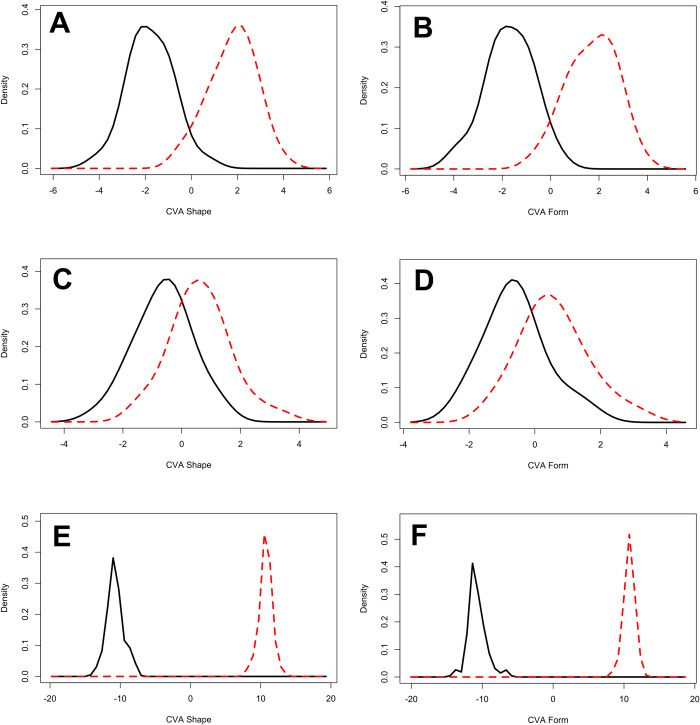
Distribution density plots for Canonical Variance Analyses in (A, C, E) shape and (B, D, F) form comparing (Red) dog and (Black) wolf tooth pits. (A, B) 17-landmark model. (C, D) 5-Landmark model. (E, F) 30-Landmark model.